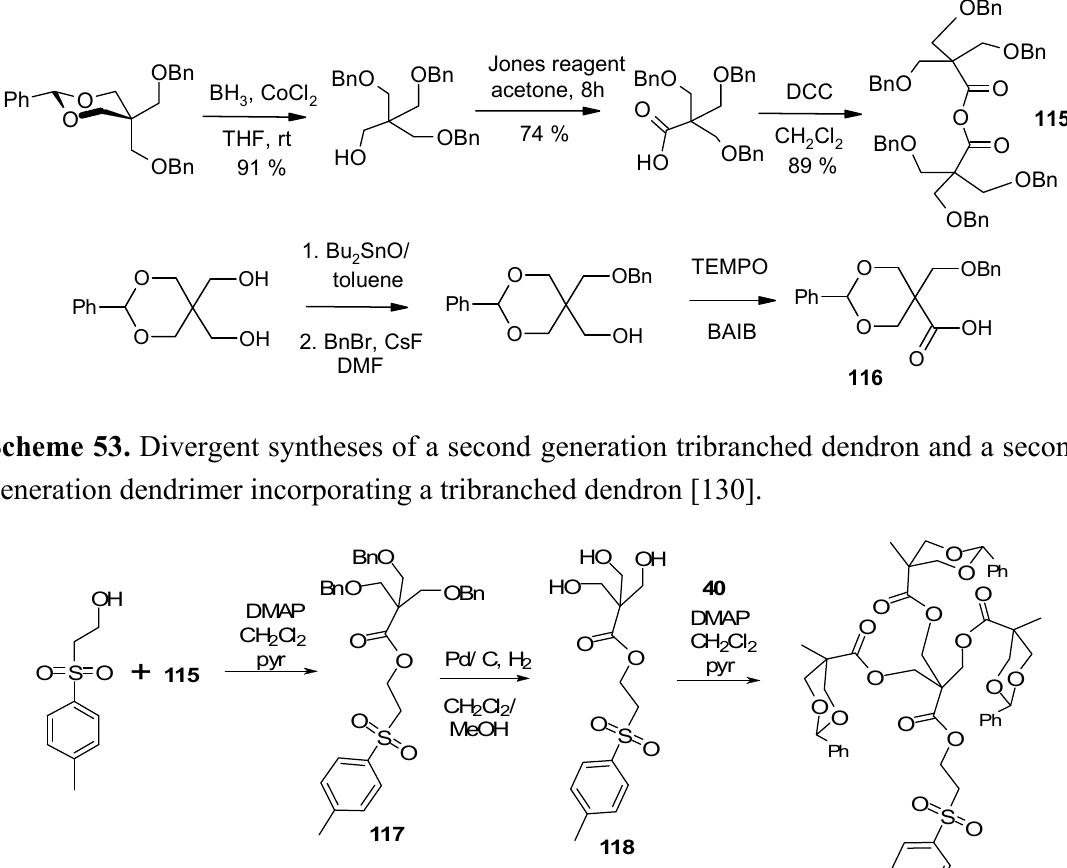
Scheme 52. Synthesis of tribranched dendrons